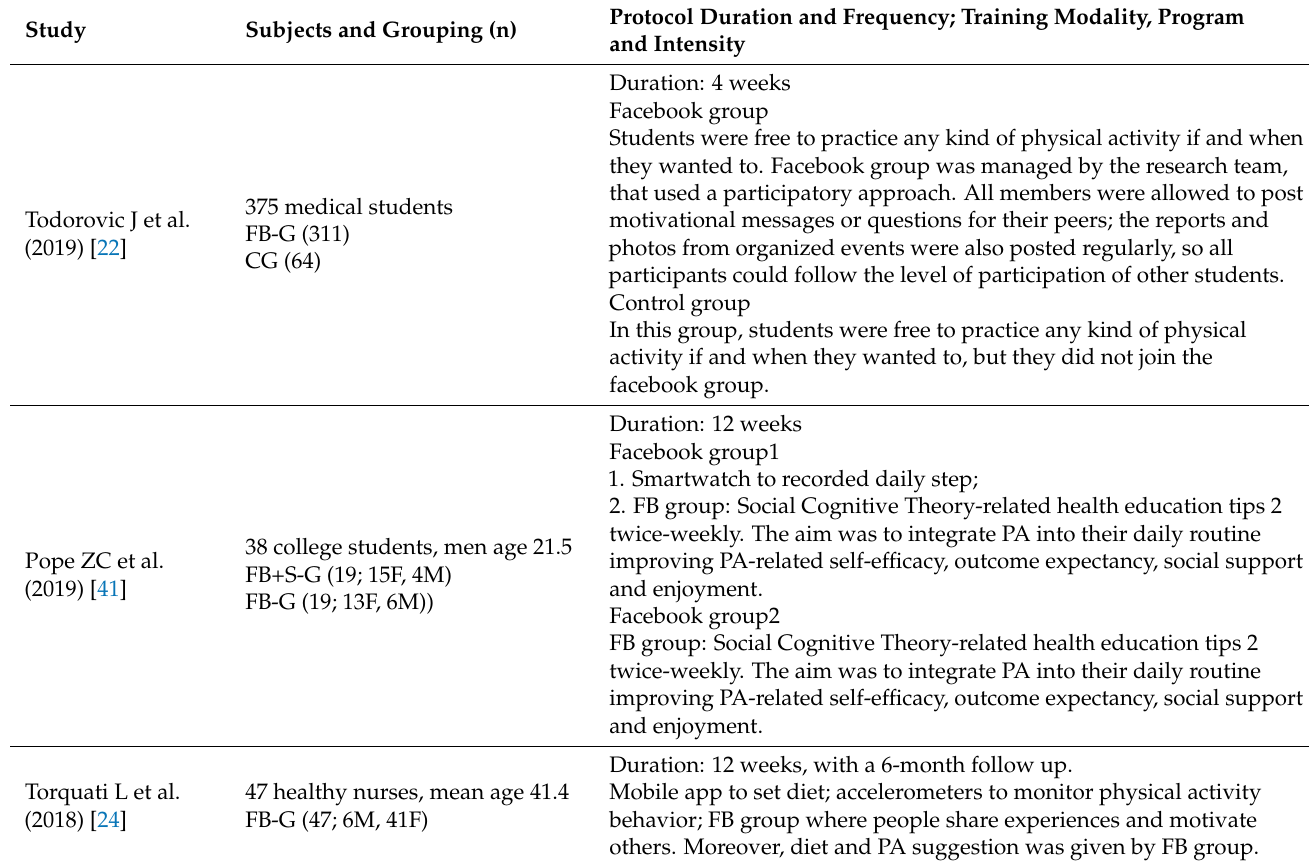
Table 3. Characteristics of the inclusion